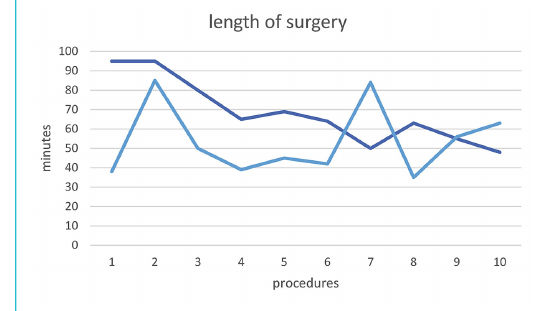
Figure 3: Duration of surgery (NiVATS = blue line, VATS = grey line).